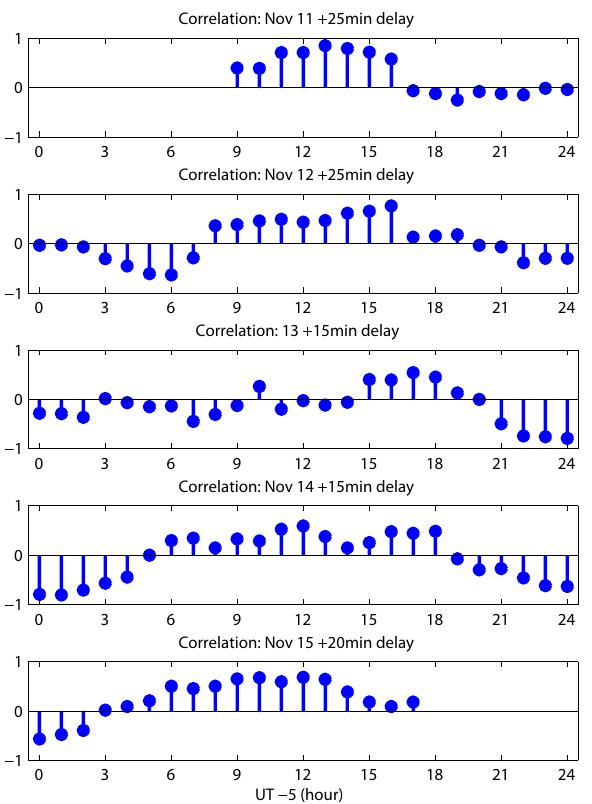
Fig. 5. During the period of 11–15 November 2003, a pattern of correlation appears to exist during the day and anti-correlation at night. Note that the time scale is set to local time at Jicamarca.